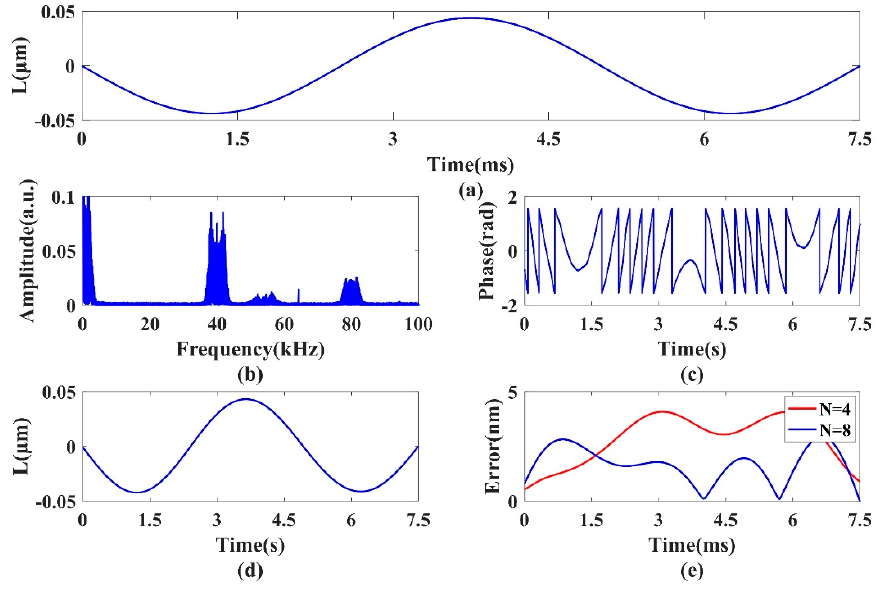
Figure 8. Experimental results of N = 4 and N = 8 with the driving voltage 0.1 V of target. ( a ) Vibration displacement of the outer objective. ( b ) Frequency spectrum of SMI signal (N = 8). ( c ) Wrapped phase from SMI (N = 8). ( d ) Reconstructed displacement (N = 8). ( e ) Displacement reconstruction error of N = 4 and N = 8.